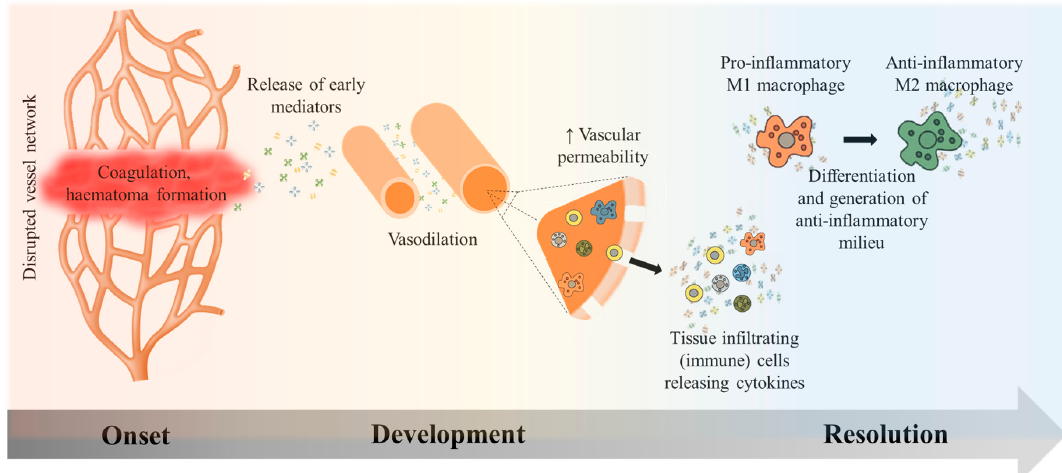
Figure 1. Course of inflammation in skeletal tissue regeneration. Signalling molecules released from the early haematoma result in vascular dilation and increased permeability. Circulating cells from the periphery can now enter the adjacent tissue. A pro-inflammatory milieu is maintained by M1 macrophages and others to declutter the site of injury. This is necessary in order to make room for the consequential anabolic anti-inflammatory progression. The anti-inflammatory milieu is dominated by M2 macrophages that create an environment, which leads to the termination of the inflammation and eventually enables tissue regeneration.